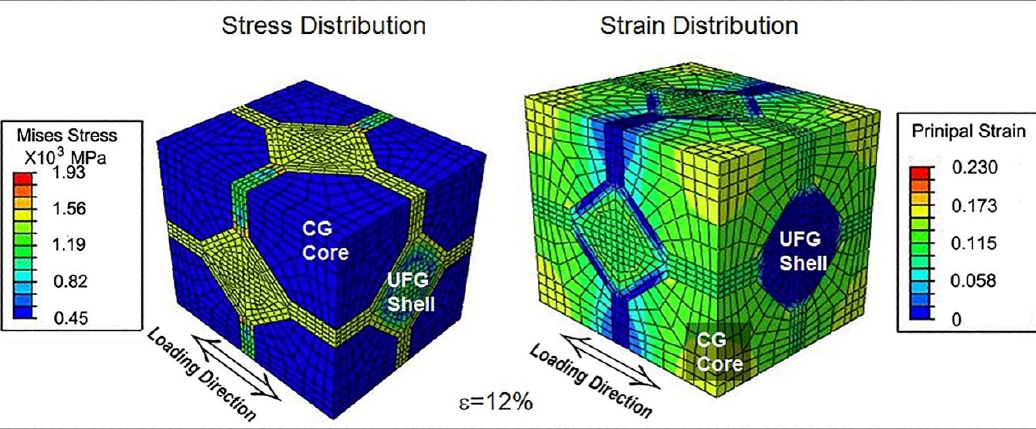
Figure 11. Numerical simulation (FEM) results of HS pure Ti illustrating the stress and strain distribution after ~12% tensile deformation [62].